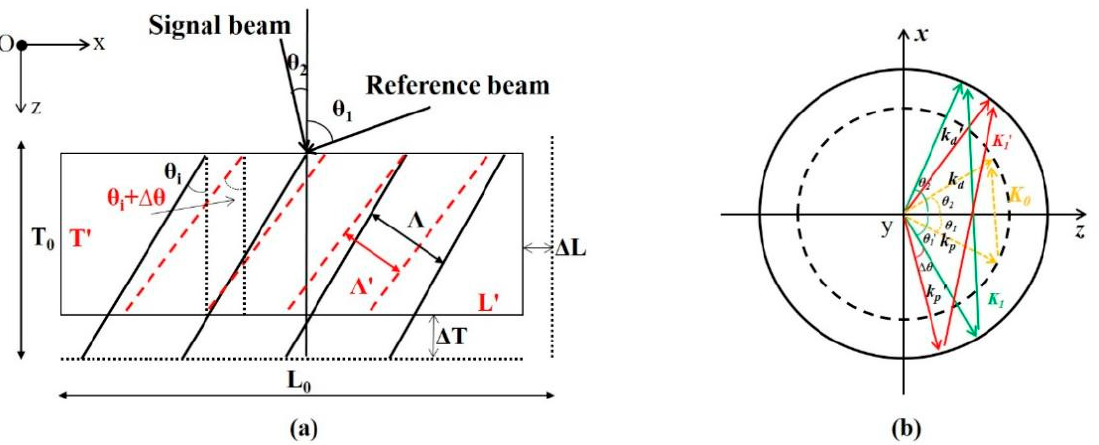
Figure 1. ( a ) The schematic diagram for the model of the dimension change in the recording medium; ( b ) the illustration of the vector diagram in the Ewald sphere.